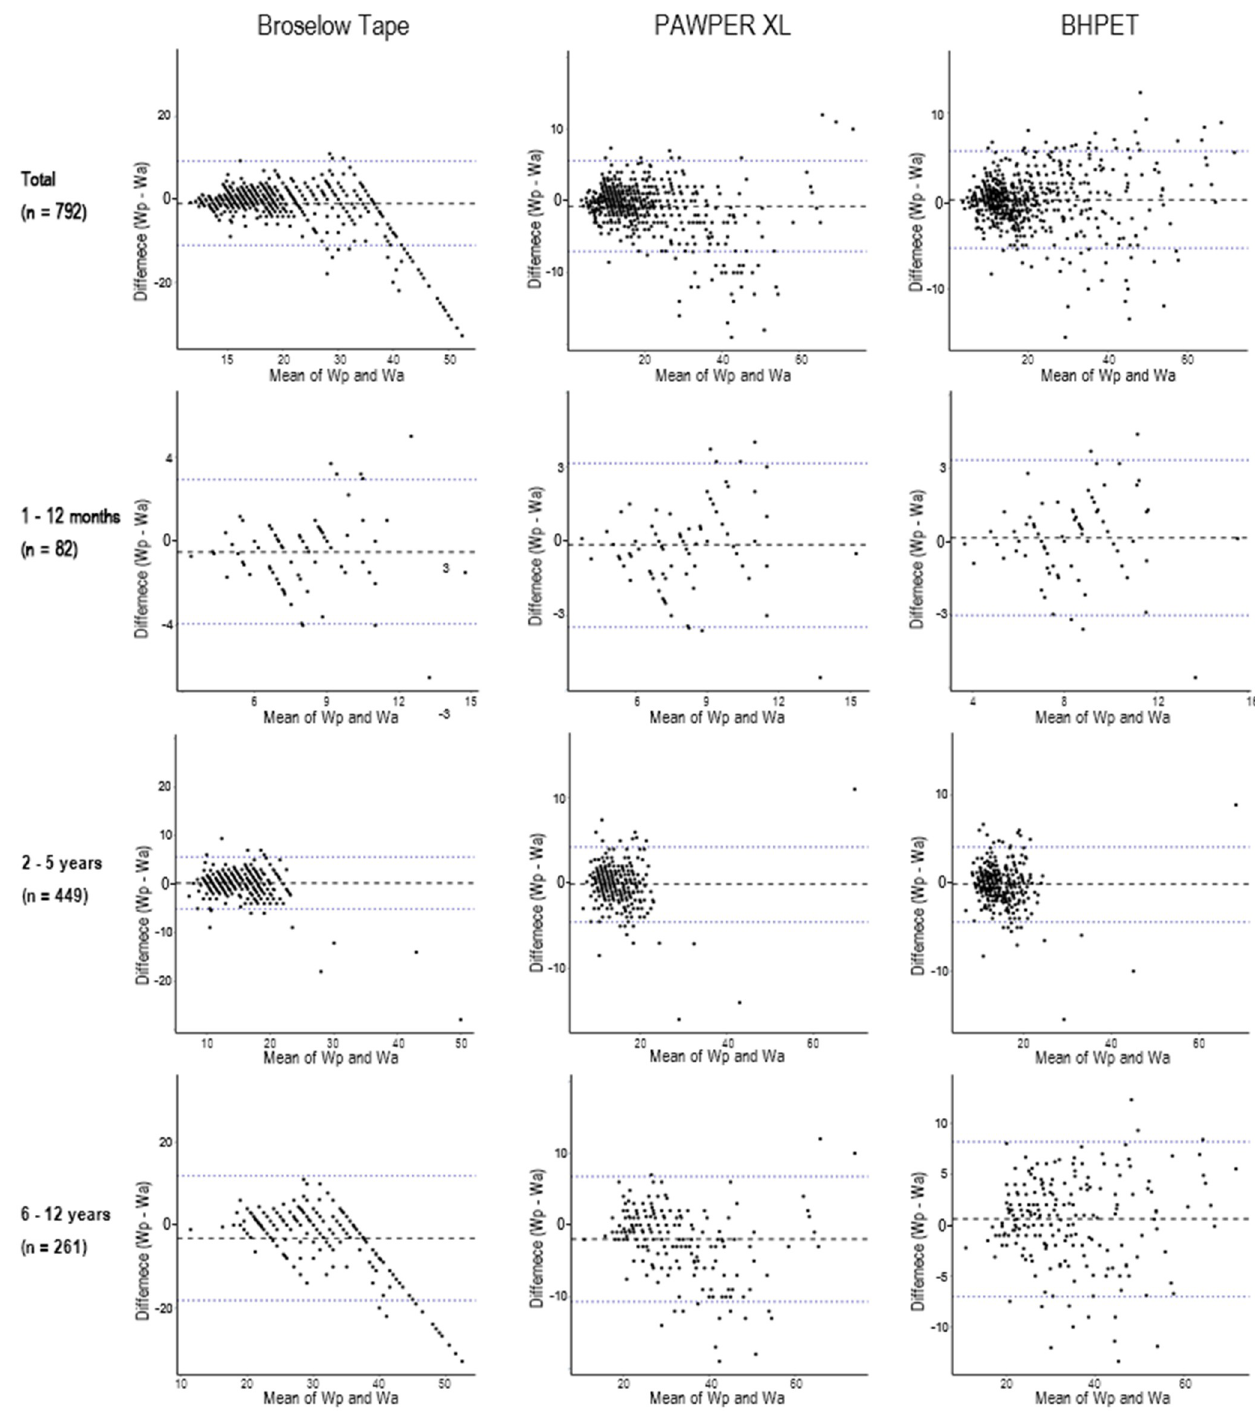
Fig 3. Bland–Altman plot with 95% limits of agreement. Wp, predicted weight; Wa, actual weight.